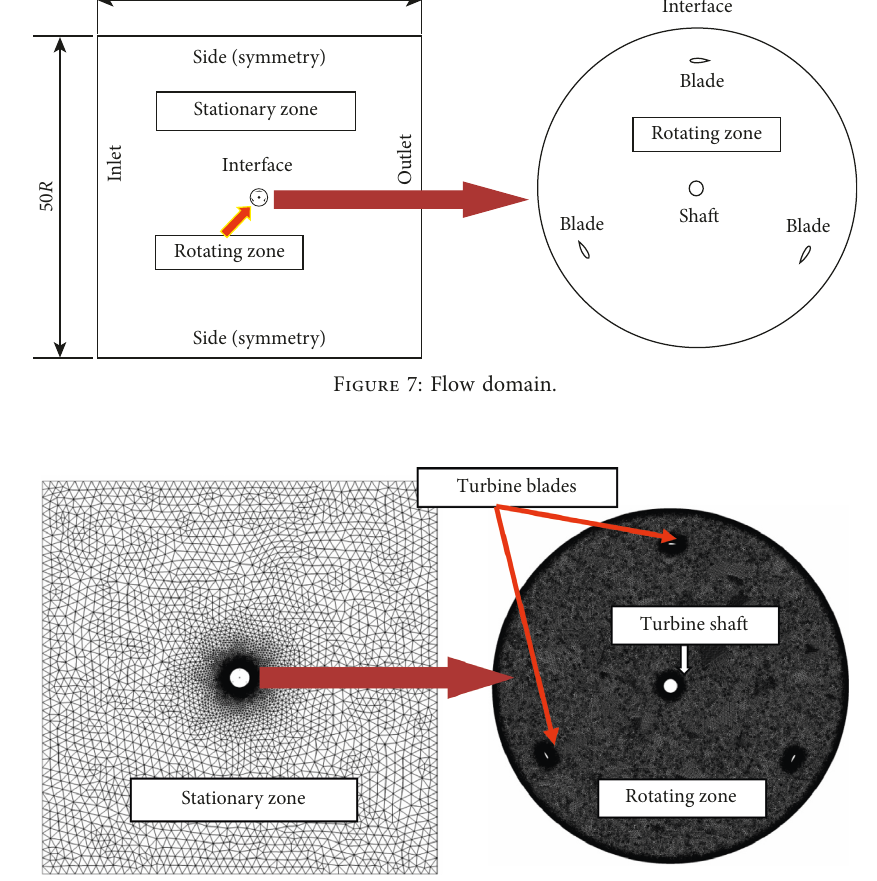
Figure 8: Unstructured grid.